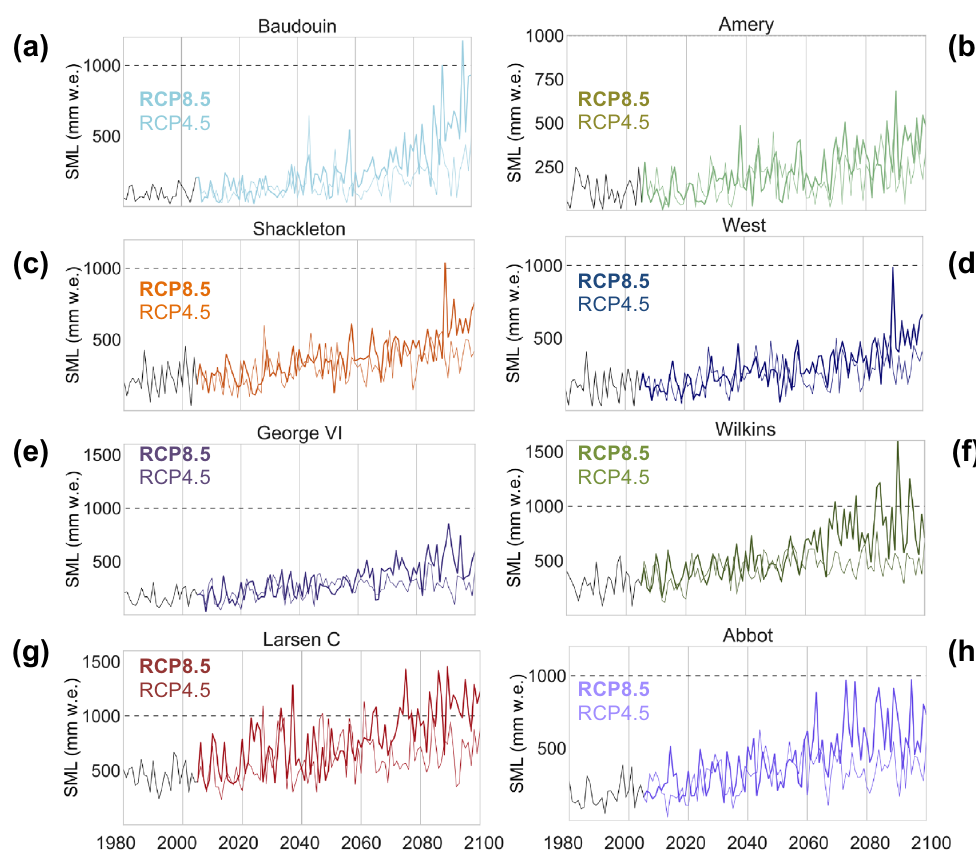
Figure 5. Meltwater production will significantly increase along the Antarctic coastline. Time series of DJF water production (SML) expected under the RCP4.5 scenario (thin lines) and under the RCP8.5 scenario (bold lines) for selected ice shelves: Baudouin ( a ), Amery ( b ), Shackleton ( c ), West ( d ), George VI ( e ), Wilkins ( f ), Larsen C ( g ) and Abbot ( h ). Time series corresponding to Ross, Ronne, and Amery are shown in the Supplementary Information. RACMO2 simulations were used (see “Methods” section). Plots were generated by using Python’s Matplotlib Library 44